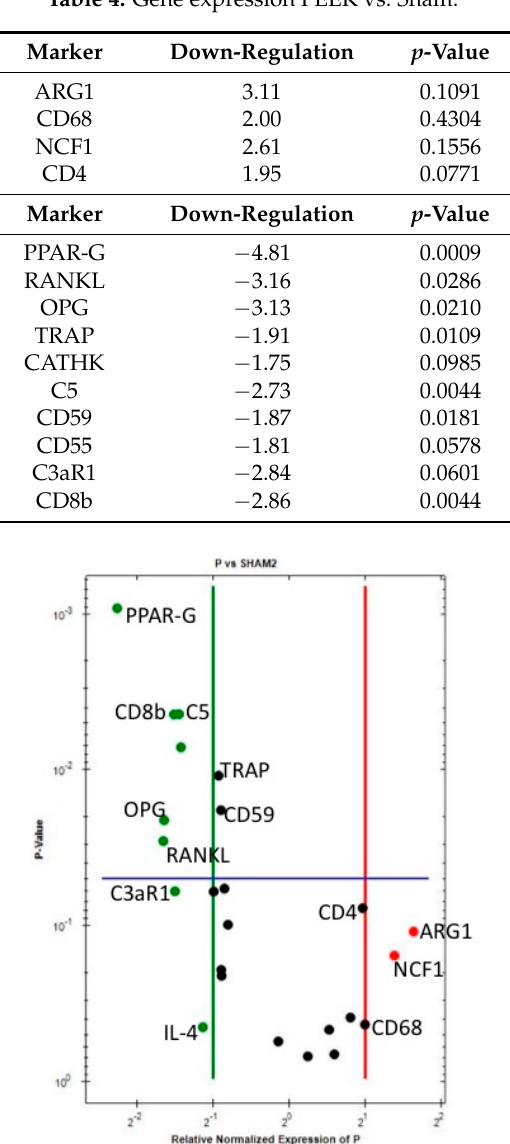
Table 4. Gene expression PEEK vs. Sham.